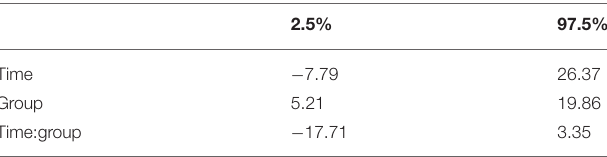
TABLE 4 | The 95% confidence intervals from multiple imputation using mice package in